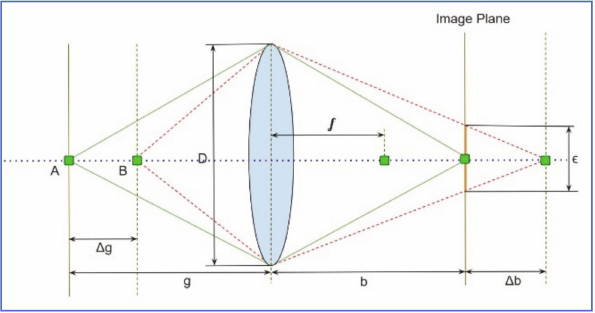
Figure 20. Close objects to the camera are projected as a blurry disk on the image plane